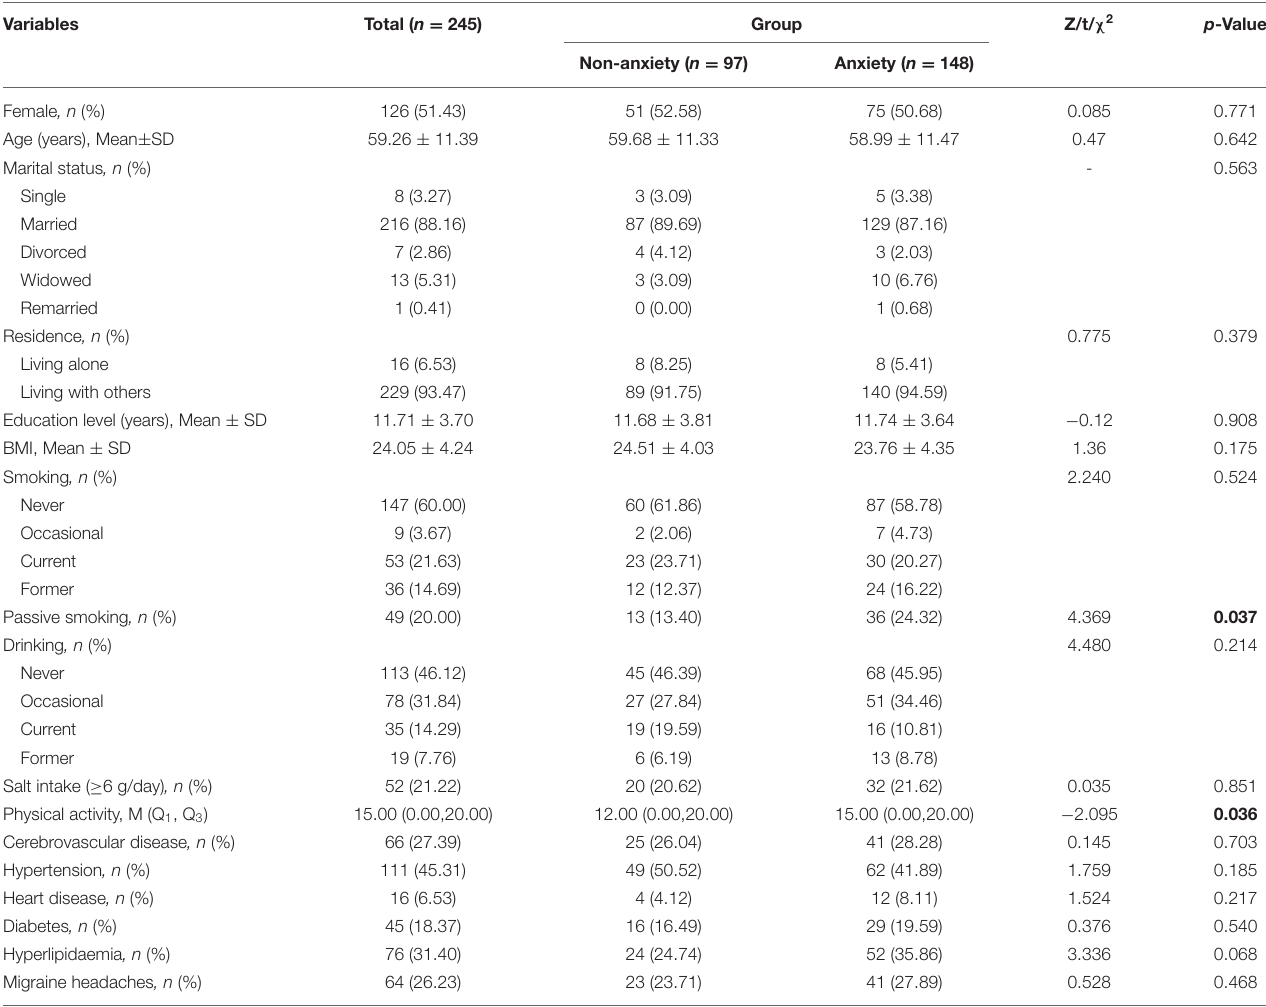
TABLE 1 | Comparison of demographic information in CSVD patients with and without anxiety symptoms.